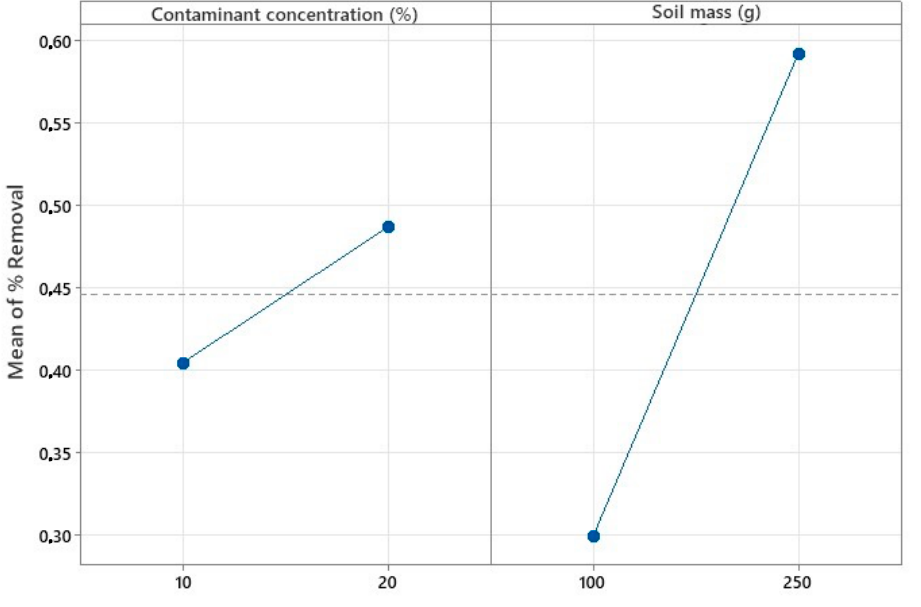
Figure 4. Main effects plot for oil removal (%) (fitted Figure 4. Main e ff ects plot for oil removal (%) ( fi tt ed means).